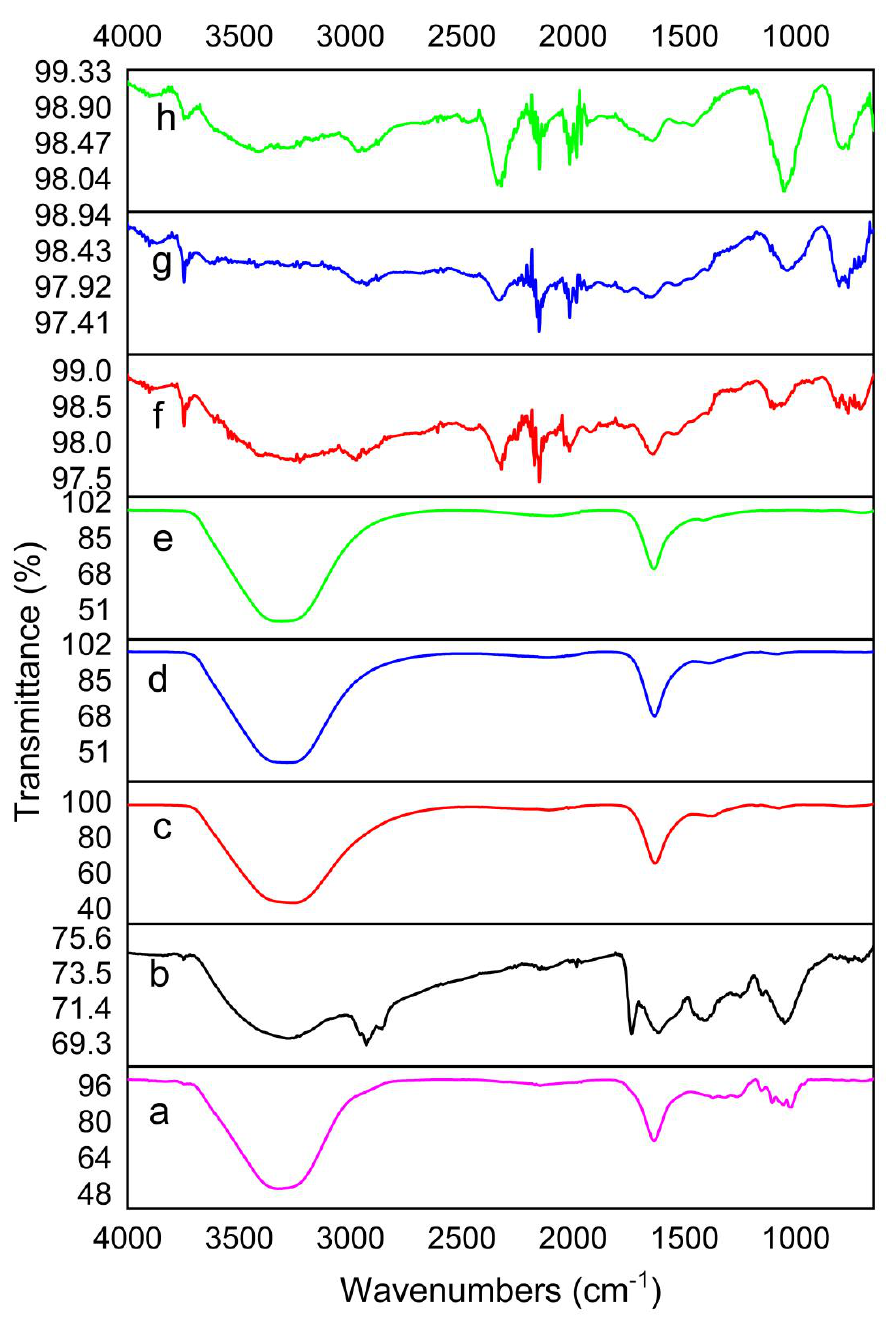
Figure 2. FTIR spectra of ( a ) MCF alone, ( b ) synthesised AgNPs, ( c ), microwave-synthesised TiO 2 NPs ( d ) TiO 2 /AgNCs, ( e ) ZnO/TiO 2 /AgNCs and ( f ) calcined TiO 2 NPs, ( g ) TiO 2 /AgNCs and ( h ) ZnO/TiO 2